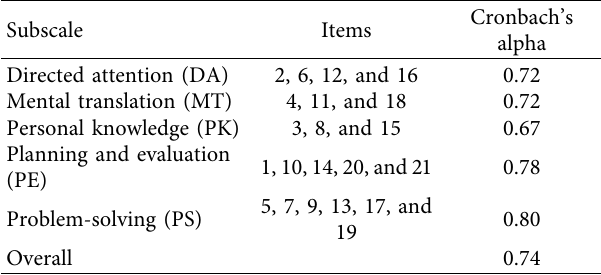
Table 1: Distribution of items on